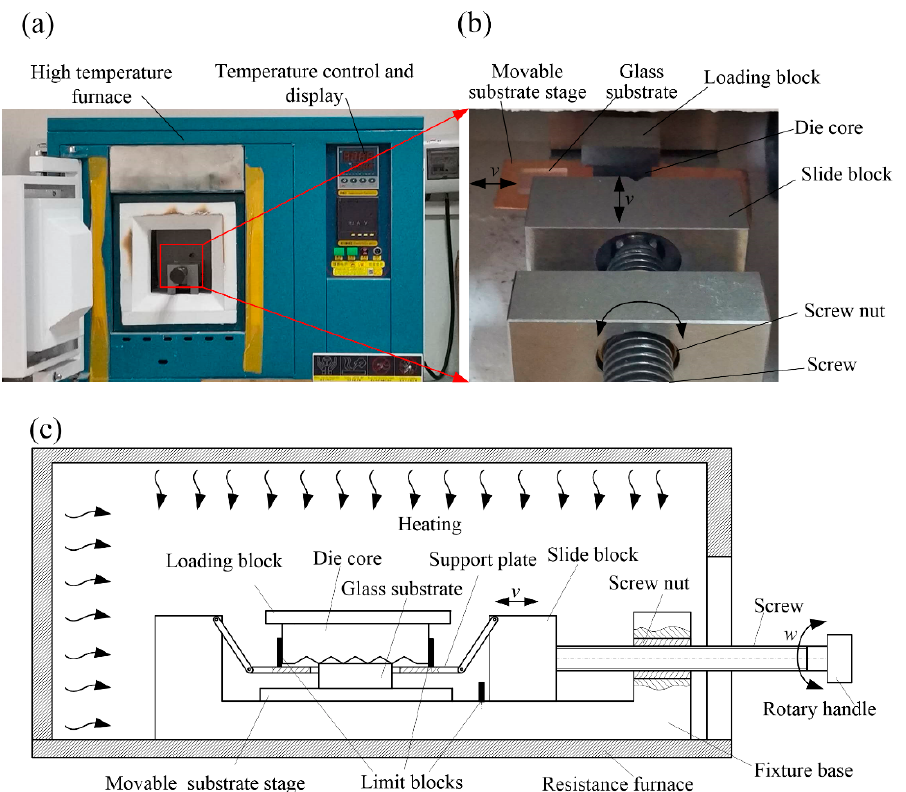
Figure 3. Experiment setup of hot-embossing glass-microprism array: ( a ) high-temperature furnace; ( b ) magnified view of experimental scene of hot-embossing glass-microprism array; ( c ) schematic diagram of principle of hot-embossing glass-microprism array.